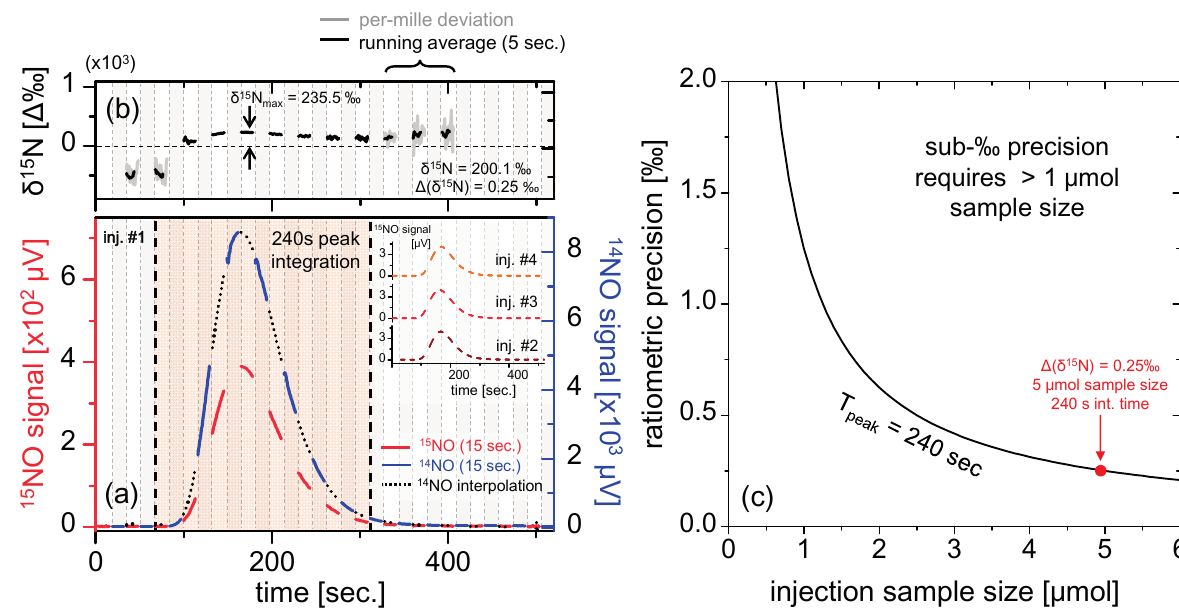
Figure 6. ( a ) Real-time measurement of 5 μ mol injection of KNO 3 (500 μ L of 10 mM solution) via line-switching every 15 s at 50% duty cycle for each isotope. The blue, red and black segments correspond to [ 14 Ñ] S , [ 15 Ñ] S and interpolated [ 14 Ñ] S respectively. The resulting peak has FWHM of ~100 s, obtained in a flow rate of 64 sccm, and the inset shows three more repeat injections (only [ 15 Ñ] S is shown for clarity); ( b ) Ratiometric curves derived from the quotient of [ 15 Ñ] S ( t ) and interpolated [ 14 Ñ] S . A clear time dependent curvature is apparent, with a maxima occurring at the measurement peak; ( c ) Calculation of ratiometric precision vs. sample size, using data obtained from ( a ). Generally, samples >1 μ mol NO 3 − are required to ensure sub-permil precisions over the span of the